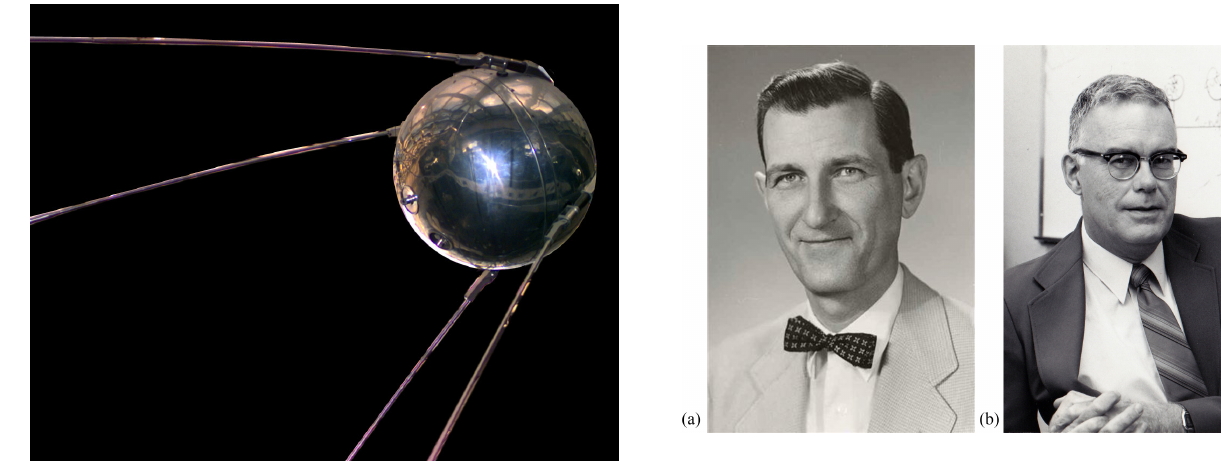
Figure 2. (a) William E. Gordon (1918–2010), physicist and as- tronomer. He proposed the incoherent scatter technique in 1958. (b) Kenneth L. Bowles (1929–2018), electrical engineer and com-